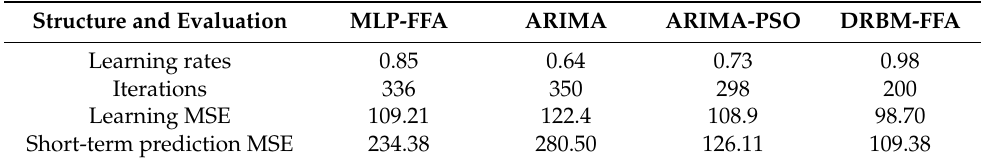
Table 3. The detail prediction errors